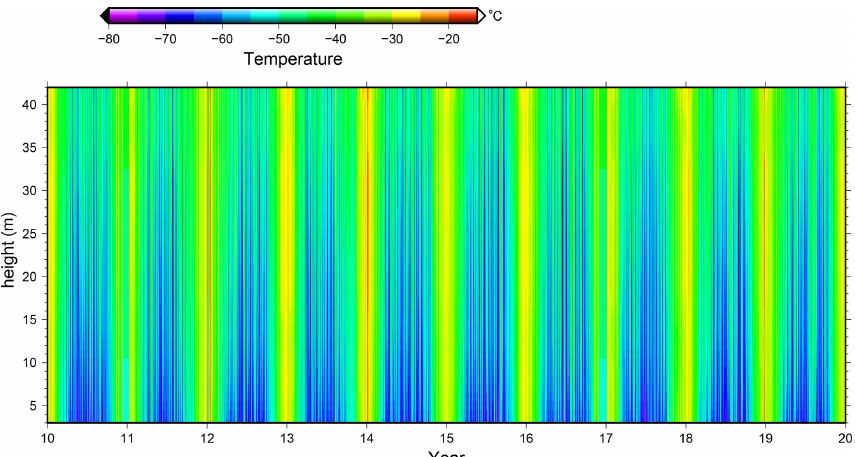
Figure 2. 10-year record (2010–2019) of daily-mean atmospheric temperature in ◦ C from the six thermohygrometers installed between 3 and 42m above the surface.